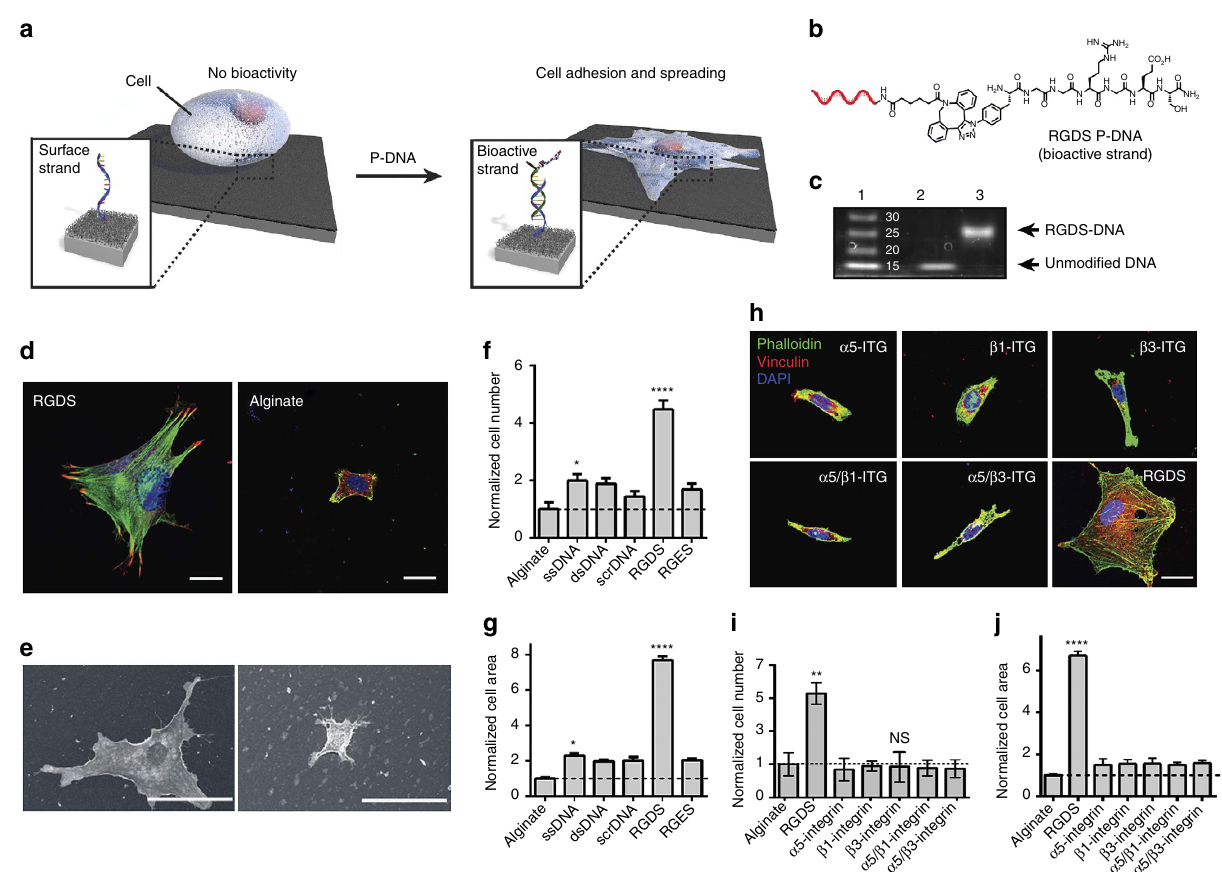
Figure 1 | Cell adhesion on RGDS P-DNA modified surfaces. ( a ) Schematic representation of fibroblast adhesion and spreading. ( b ) Chemical structure of RGDS P-DNA (DNA strand is represented schematically in red). ( c ) Polyacrylamide gel electrophoresis of RGDS P-DNA: lane 1, molecular weight ladder, lane 2, unmodified DNA, lane 3, purified DNA-RGDS conjugate. ( d ) Confocal microscopy images of fibroblasts 24h after being plated on either RGDS P-DNA or alginate surfaces, ( e ) scanning electron micrographs of fibroblasts 24h after being plated on either RGDS P-DNA or alginate surfaces . Scale bars for fluorescent images; 20 m m and for micrographs: 50 m m. ( f ) Normalized cell number and area ( g ) of fibroblasts plated on various coated surfaces (all values were normalized relative to alginate, n ¼ 5). ( h ) Confocal images of fibroblasts treated with integrin-blocking antibodies and plated on RGDS P-DNA surfaces for 24h (staining for actin (phalloidin, green), vinculin (red) and nuclei (DAPI, blue) reveals the cytoskeletal organization, focal adhesions and cell nuclei, respectively. Scale bar: 20 m m. ( i ) Normalized number and area ( j ) of cells from part h . All values were normalized relative to alginate; n ¼